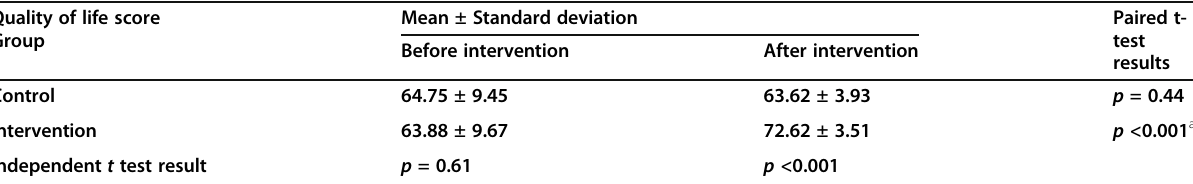
Table 3 Comparison of patients ’ quality of life scores before and after the intervention in intervention and control groups